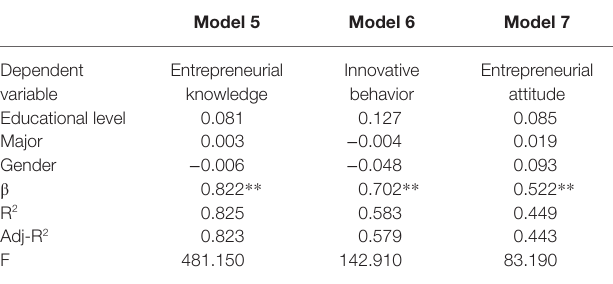
TABLE 8 | Regression analysis results (independent variable: IEE).